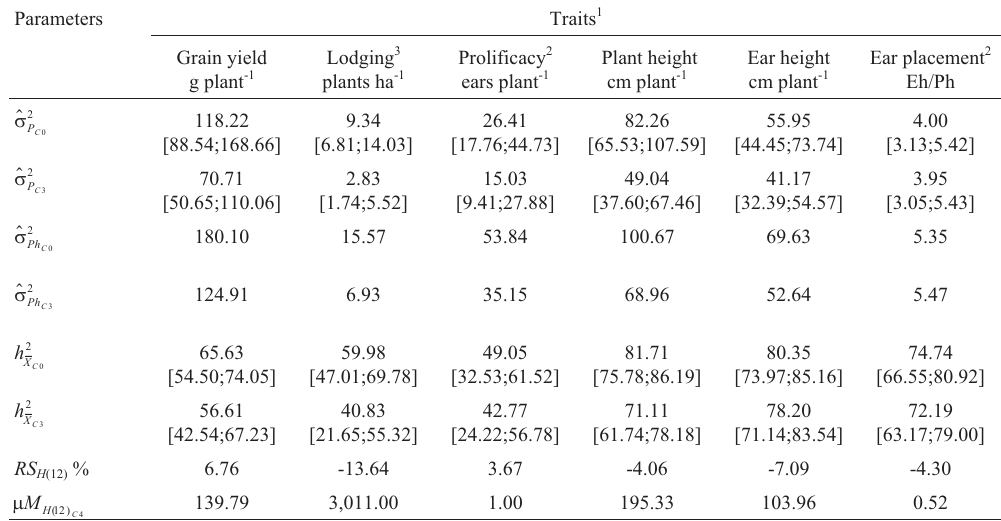
Table 3 - Estimates of genetic ( (cid:1) (cid:1) responses to selection (